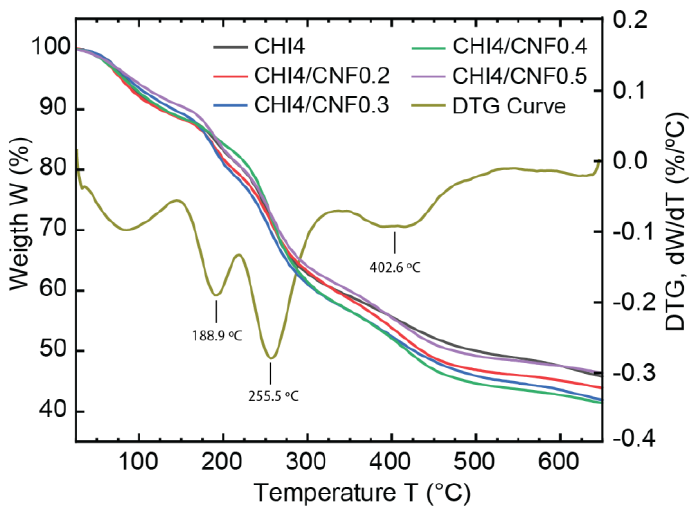
Figure 8. Thermogravimetric analysis (TGA) and derivative thermogravimetry (DTG, exemplified to analyze the nanocomposite fiber CHI3/CNF0.3) of the CHI/CNF spun fibers of varied composi-